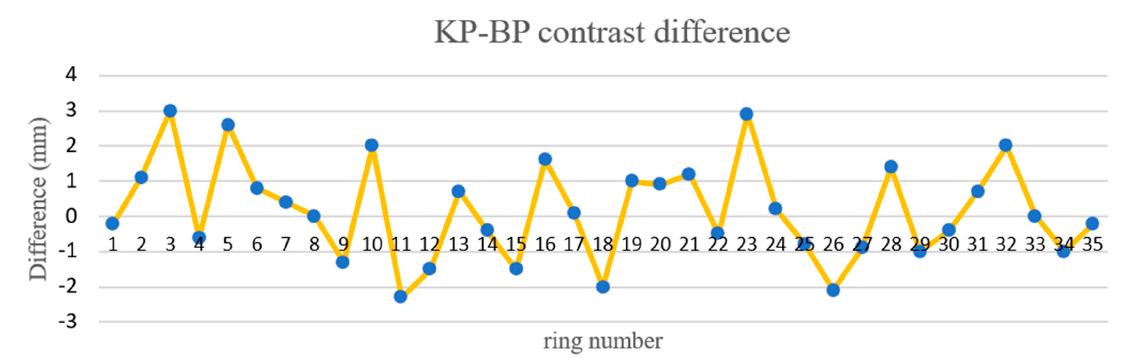
Figure 16. BP-A1P contrast difference. Figure 16. BP–A1P contrast difference.